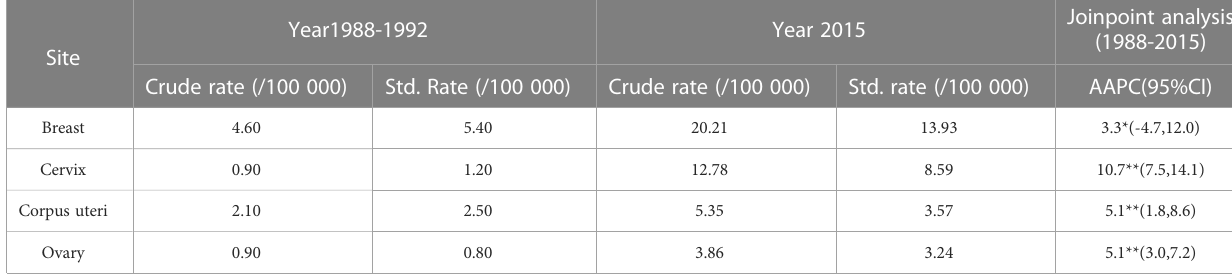
TABLE 1 Crude incidence rates, age standardized incidence and Joinpoint analyses for 1988 through 2015 in Changle.